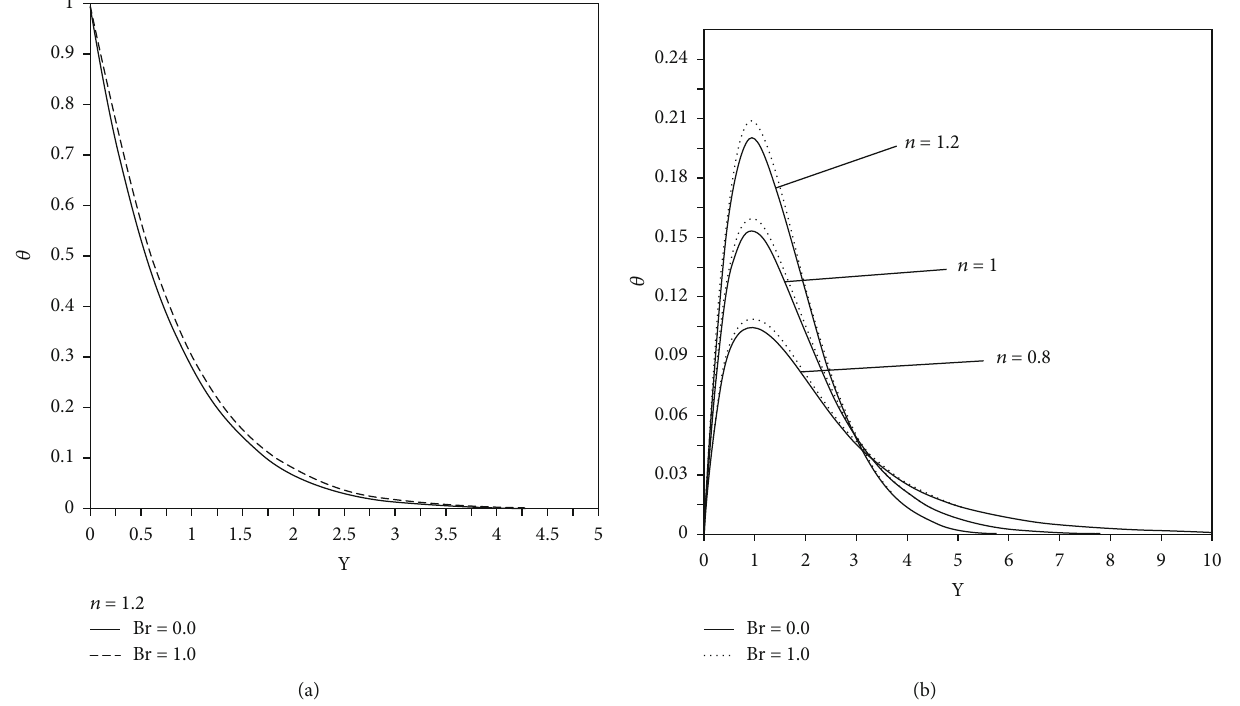
Figure 4: (a) Thermal pro fi le and (b) velocity pro fi le for Pr